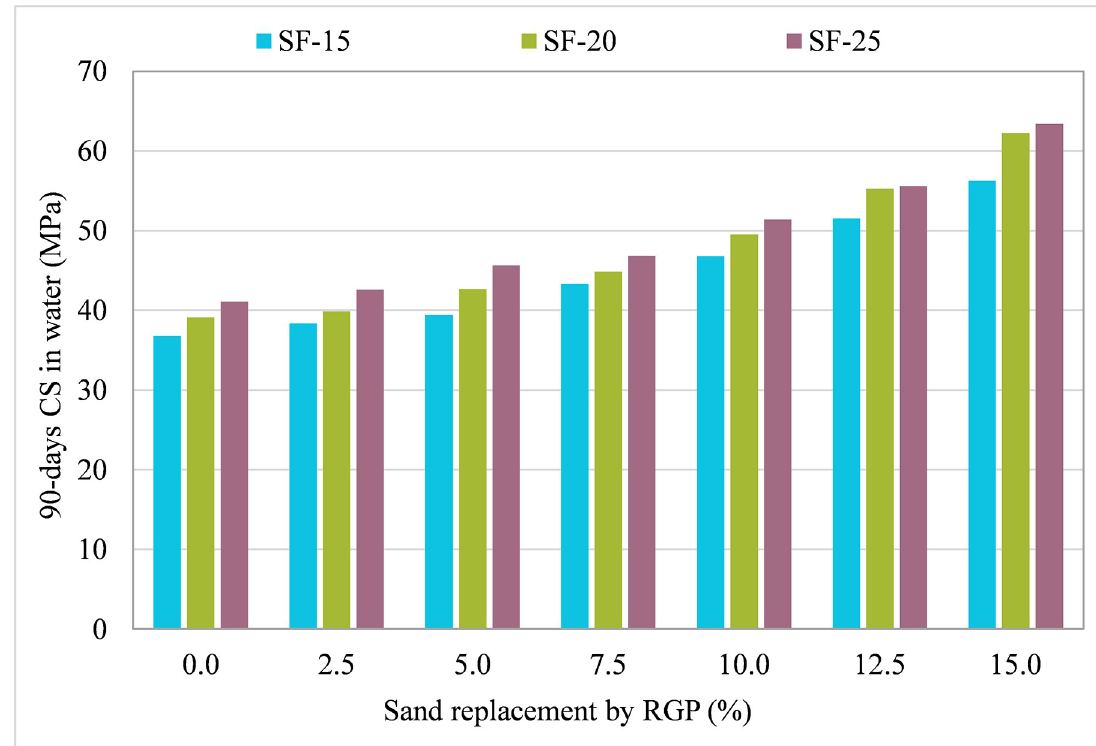
Fig 7. 90-day CS of samples incorporating RGP as sand replacement in plain